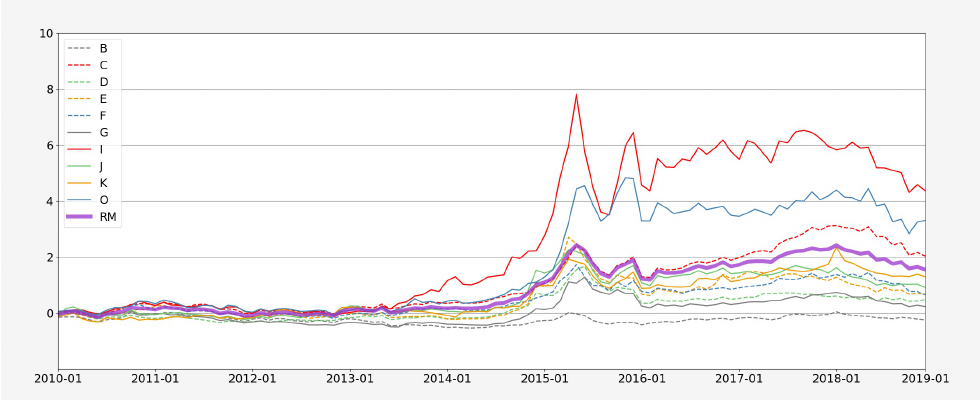
Figure 3. MCASI’s return and sector portfolio’s return. Notes: Figure 3 produces time-series charts of the cumulative returns of the sector portfolios. The tags and full names of these sector portfolios can be found in Panel A of Table 8. MCASI’s return of RM is described in the Variable Definitions section. The sample period extends from January 2010 to December